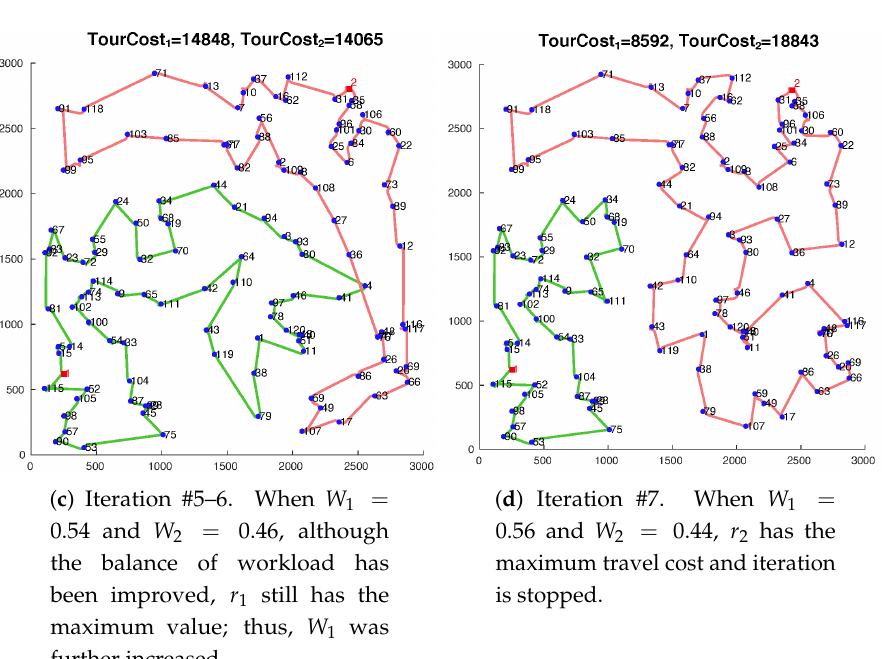
Figure 1. Routes produced with Algorithm 1 for an instance of 120 targets in a 3000 × 3000 space with symmetric costs: As the routes in ( b ) have the lowest maximum travel cost, 14,766, it has been chosen for the final